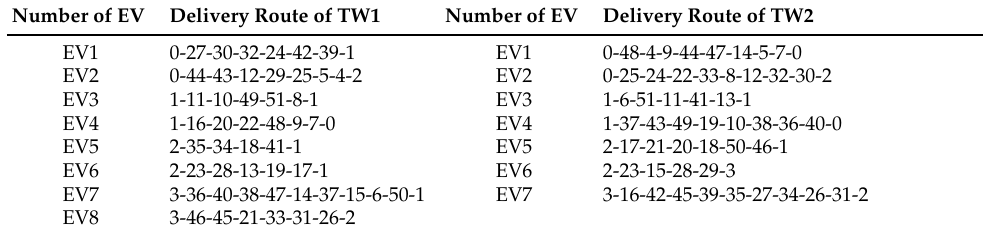
Table 6. The specific routes of the delivery scheme for case 1.